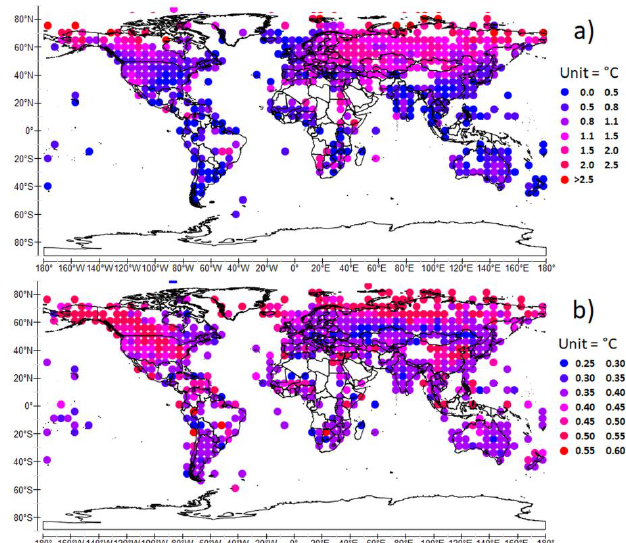
Figure 5. ( a ) The response to anthropogenic forcing within the surface temperature 𝑇 𝑠 in 2015; ( b ) the natural variations in temperature 𝑤 𝑁𝐴 𝑆𝑆𝑇 𝑁𝐴 + 𝑤 𝑁𝑃 𝑆𝑆𝑇 𝑁𝑃 in the northern hemisphere and 𝑤 𝑆𝐴 𝑆𝑆𝑇 𝑆𝐴 + 𝑤 𝑆𝑃 𝑆𝑆𝑇 𝑆𝑃 + 𝑤 𝑆𝐼 𝑆𝑆𝑇 𝑆𝐼 in the southern hemisphere. 1970 is the year from which the temperature change is estimated. Areas without dots have no data. Data are provided by the Climatic Research Unit (CRU) at the University of East Anglia [27].